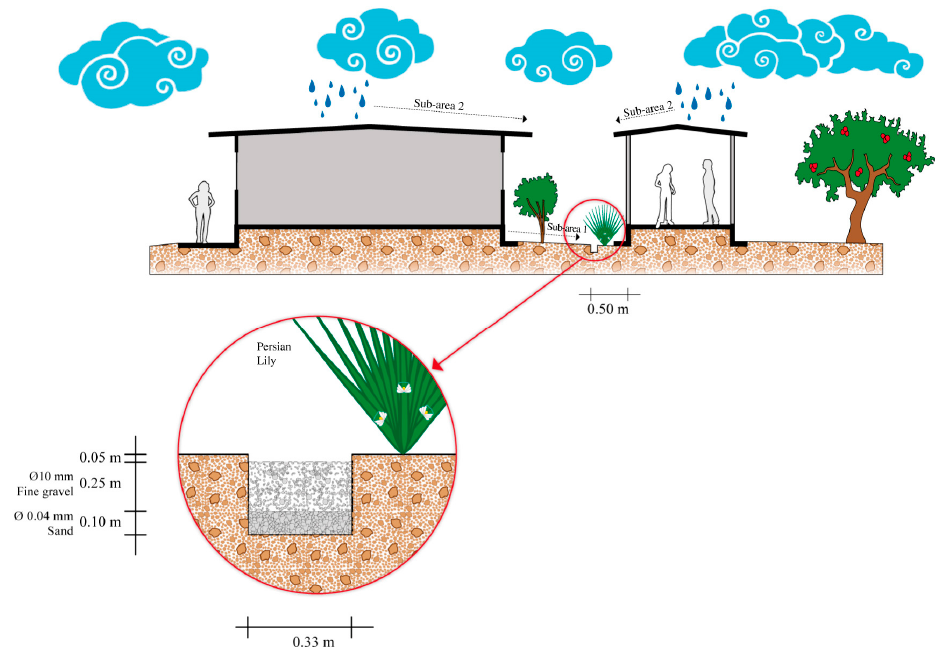
Figure 4. Design of the infiltration trench.